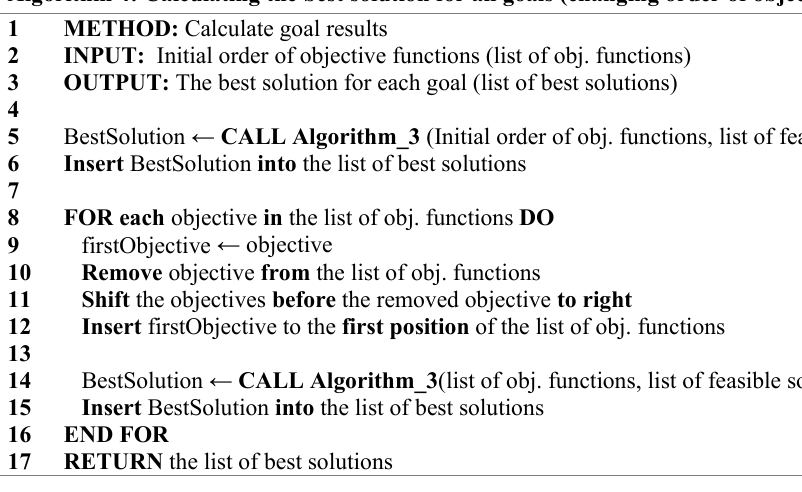
Algorithm 4: Calculating the best solution for all goals (changing order of objective